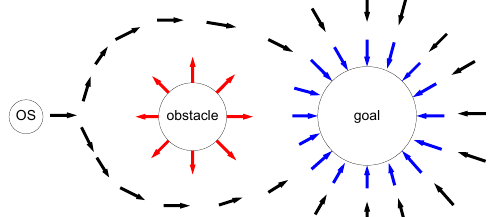
Figure 1. Diagram of traditional artificial potential field method [27].